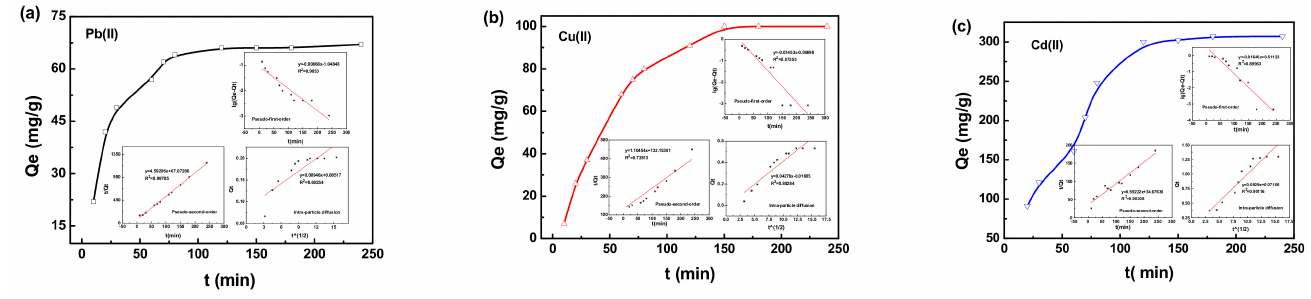
Figure 4. Effect of contact time on the adsorption capacity of the XMPC composite particles (303 K 1 g/L, pH = 5.5); adsorption of Pb(II) ( a ), Cu(II) ( b ), and Cd(II) ( c ). Insets: pseudo-first-order kinetic model, pseudo-second-order kinetic model, and intra-particle diffusion